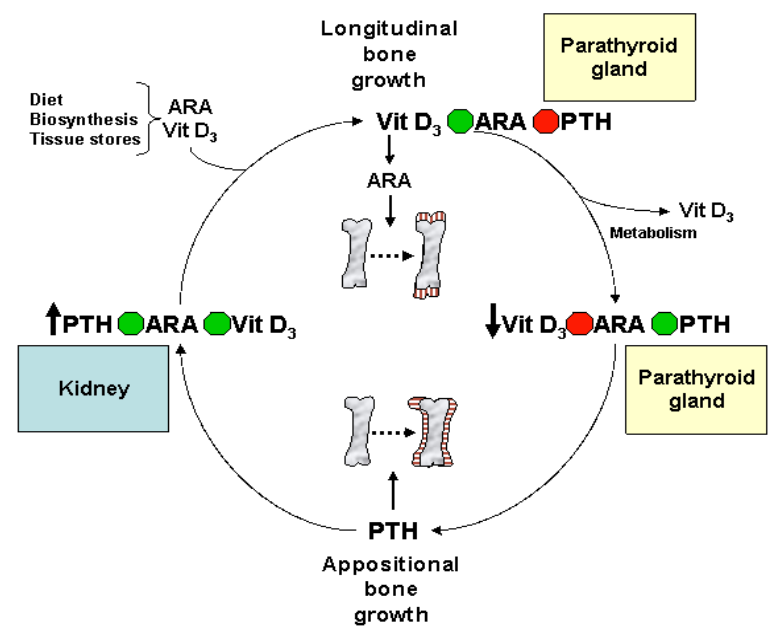
Figure 5. The role of ARA in bone development and homeostatic regulation of vitamin D 3 and parathyroid hormone (PTH) levels along the parathyroid gland-kidney axis during growth. ARA and vitamin D 3 are acquired from the diet and/or from endogenous sources. ARA mediates vitamin D 3 regulation of chondrocyte proliferation and growth plate mineralization during bone elongation. As vitamin D 3 is metabolized and levels subside, ARA-dependent PTH suppression is diminished and PTH production by the parathyroid gland is upregulated. This results in increased periosteal bone mineral content (appositional bone growth). In kidney, PTH induces the ARA-mediated increase in vitamin D 3 activation and secretion, elevating the amount of vitamin D 3 in circulation. The cycle continues as the restoration of vitamin D 3 results in the ARA-dependent suppression of PTH and stimulates longitudinal bone growth.